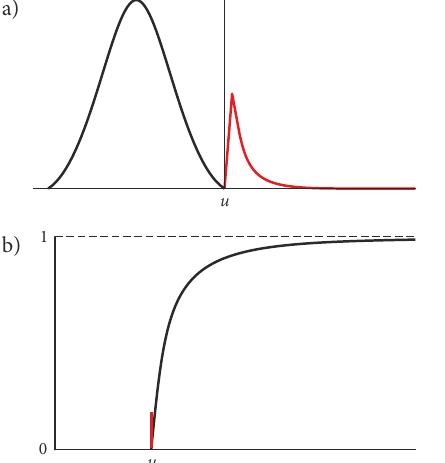
Figure 3. Distributions: a – probability distribution F (left) and extreme value distribution (GPD) (right); b – the CDF of GPD